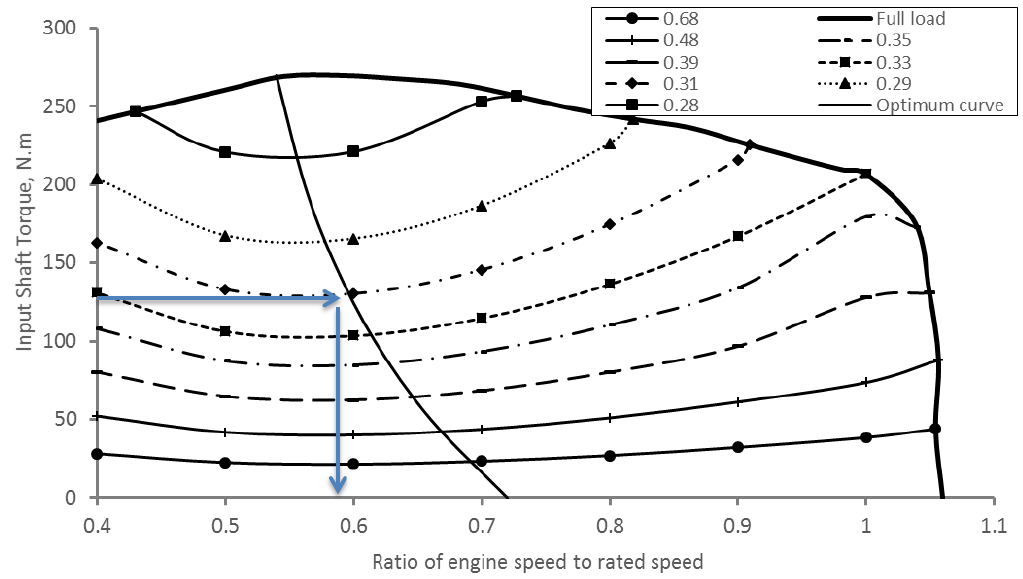
Figure 3. Optimum performance curve of specific volumetric fuel consumption map.